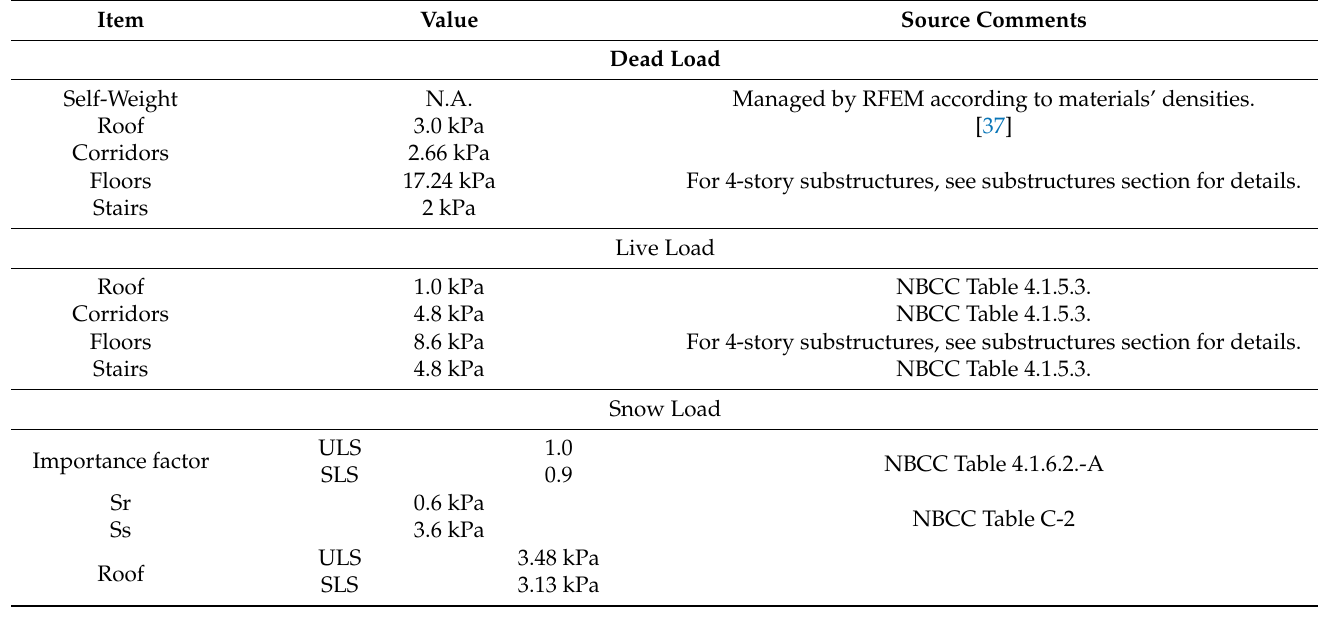
Table 1. Gravitational loads’ design data according to NBCC.